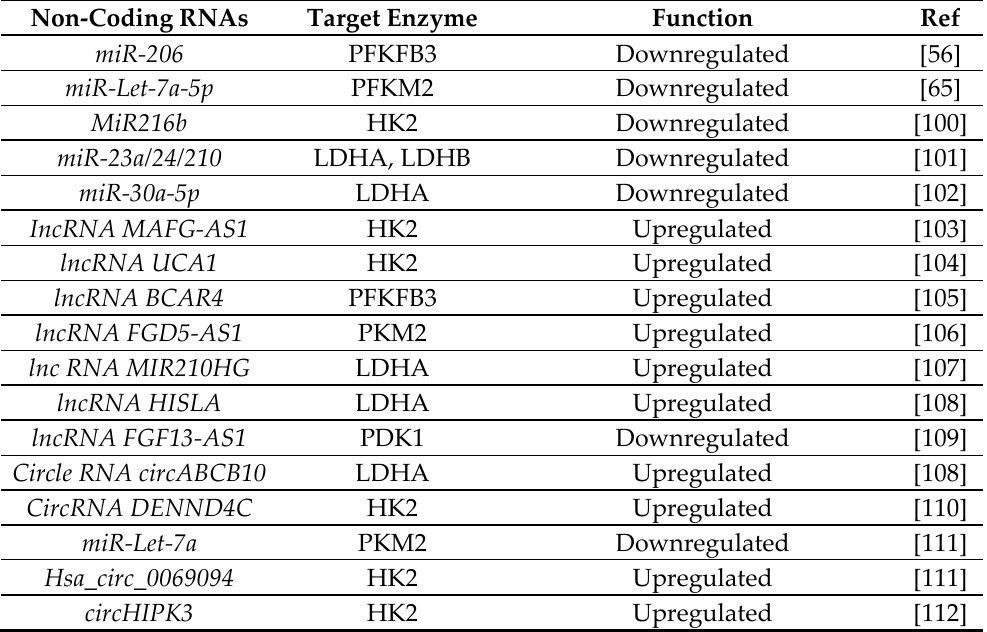
Table 1. The interplay between ncRNAs and key enzymes of aerobic glycolysis in breast cancer. Non-Coding RNAs Target Enzyme Function Ref